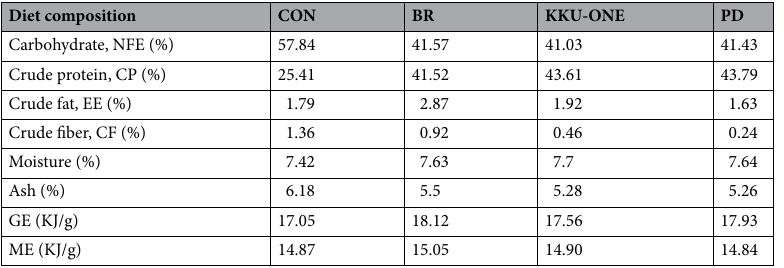
Table 5. Chemical composition of diets comprising breast meat from different chicken breeds. CON, control; BR, commercial broiler; KKU-ONE, commercial broiler × Thai native crossbred; PD, Thai native chicken (Pradu Hang Dam); NFE = Nitrogen free extract; CP = Crude protein; EE = Ether extract; GE = Gross energy; ME = Metabolizable